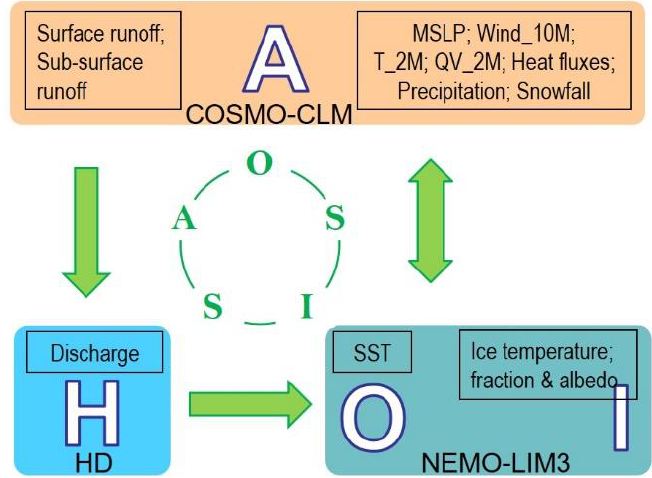
Figure 1. Schematic of GCOAST-AHOI: The Atmospheric model COSMO-CLM (CCLM) vs.5.0, the Hydrological discharge model HD vs.4.0, the ocean model NEMO vs.3.6 with sea ice model LIM3 coupled via the coupler OASIS3-MCT vs.3.